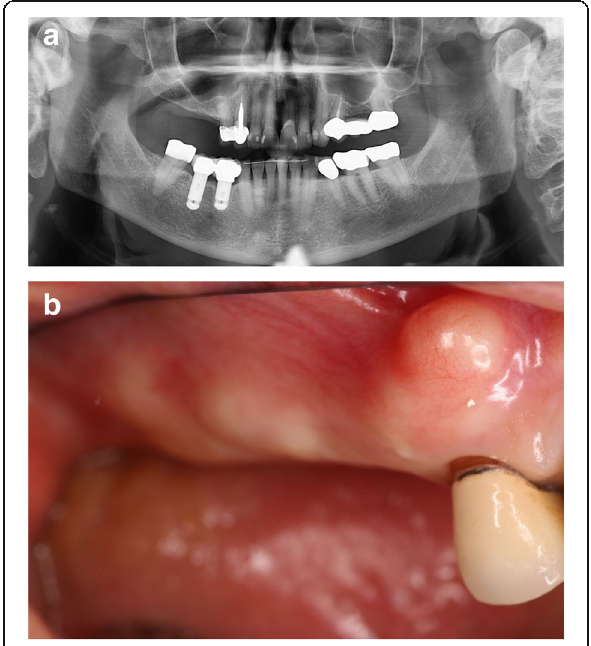
Fig. 1 a Pre-operative panoramic X-ray. b Pre-operative edentulous posterior